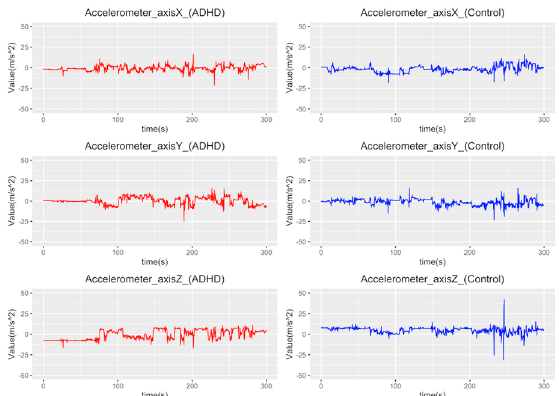
Figure 3. An example of one patient’s and one control’s variance in the accelerometer measurements in the three axes. Data indicate higher variance values of the accelerometer measurements in the x -, y -, and z -axes in the child with attention-deficit hyperactivity disorder (ADHD) than in the matched